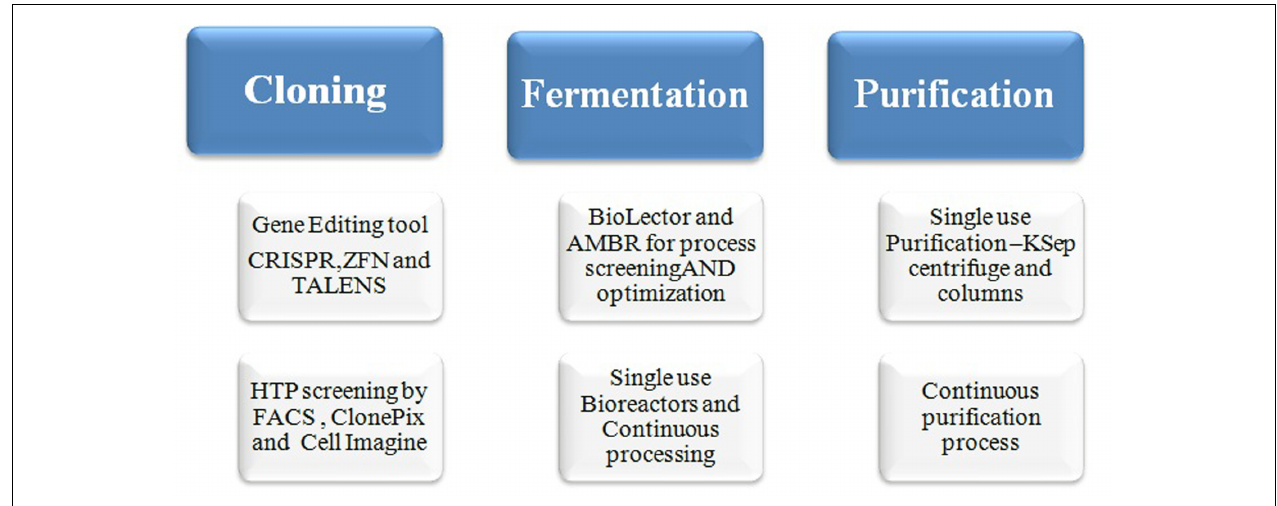
FIGURE 3 | Modern clone and process development